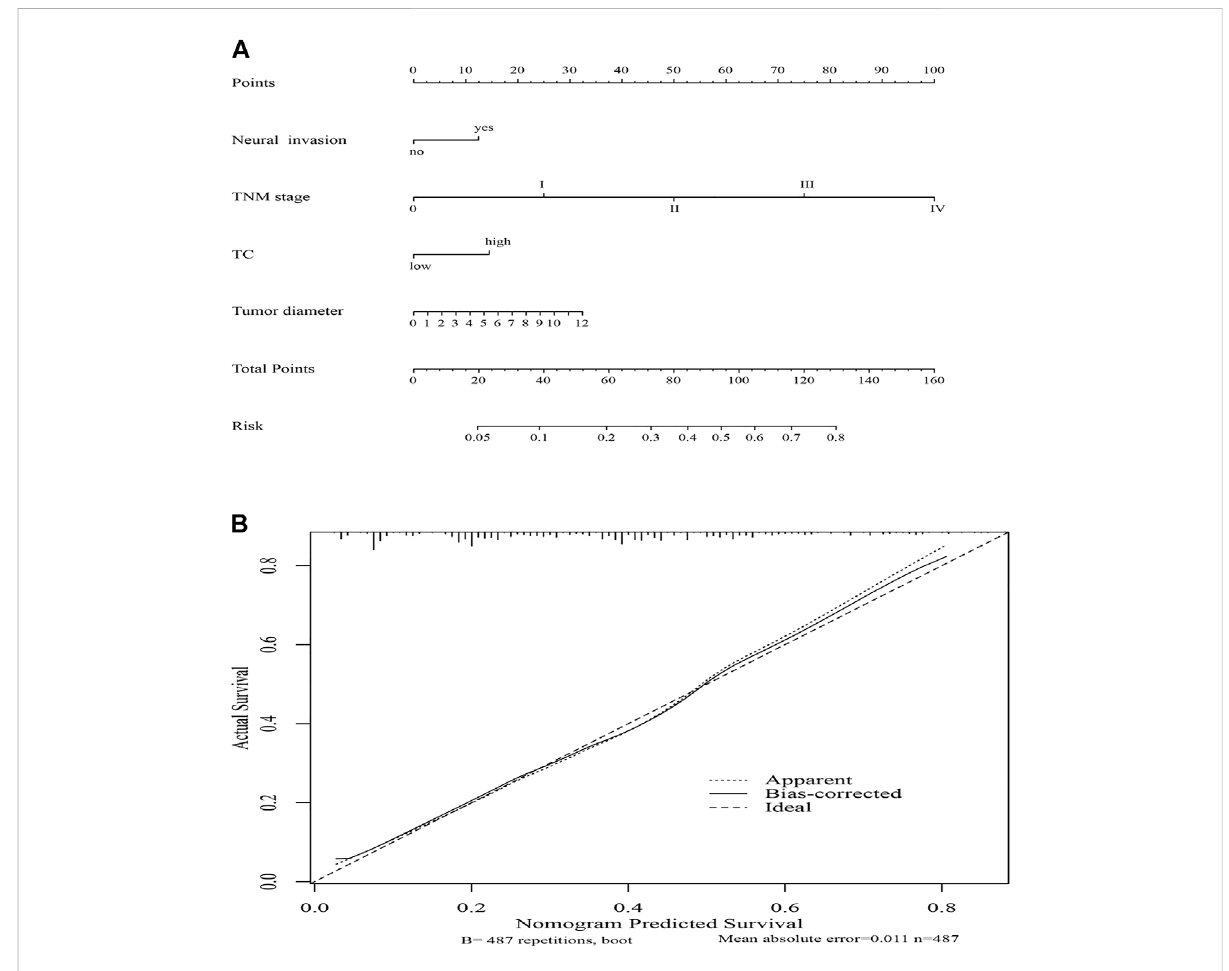
FIGURE 5 Nomogram model for death risk prediction (A) ; calibration curve of the nomogram model in the female cohort (B) .